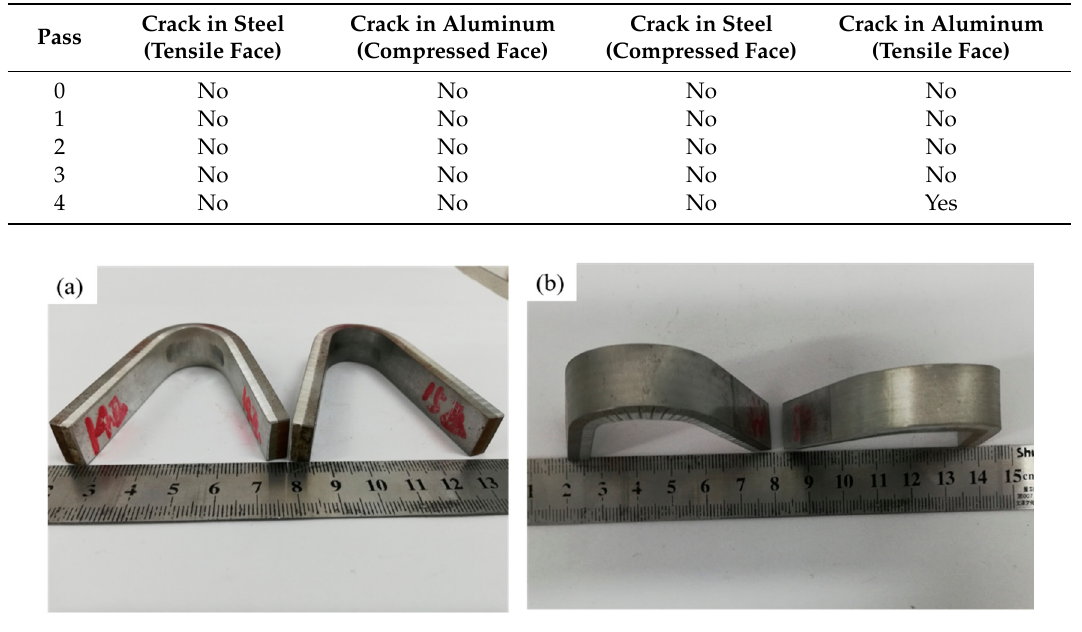
Figure 11. Bending specimens of composite plate after FSP with two passes: ( a ) compressed face; ( b ) tensile face